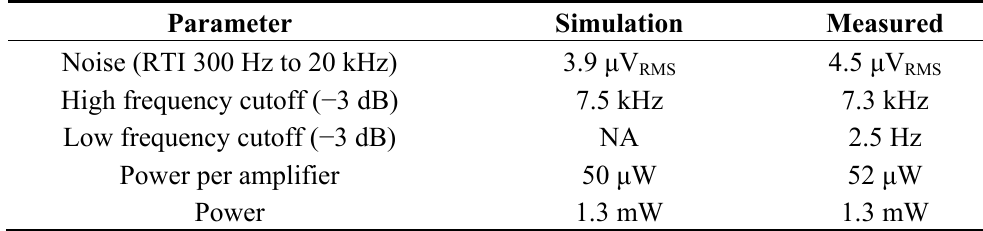
Table 1. Performance Characteristics of the Amplifier